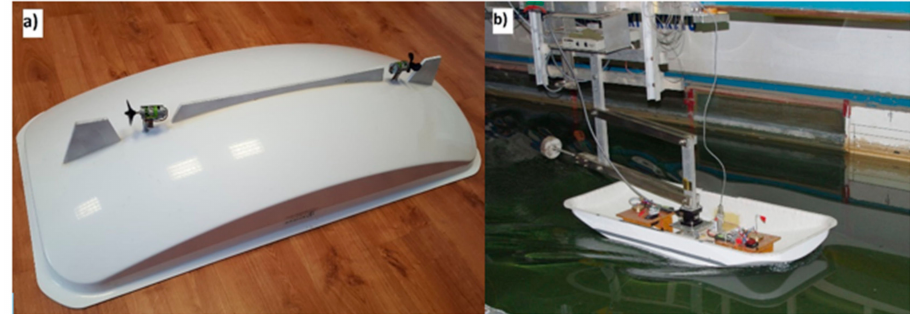
Figure3. The1:10scalemodelferry: ( a )Thefinalversionwithskegsandpropulsion,allowingmanoeuvring tests using remote control; ( b ) the model of the towing tank during tests, with a (rescaled for a real ferry) speed of 10 km / h.